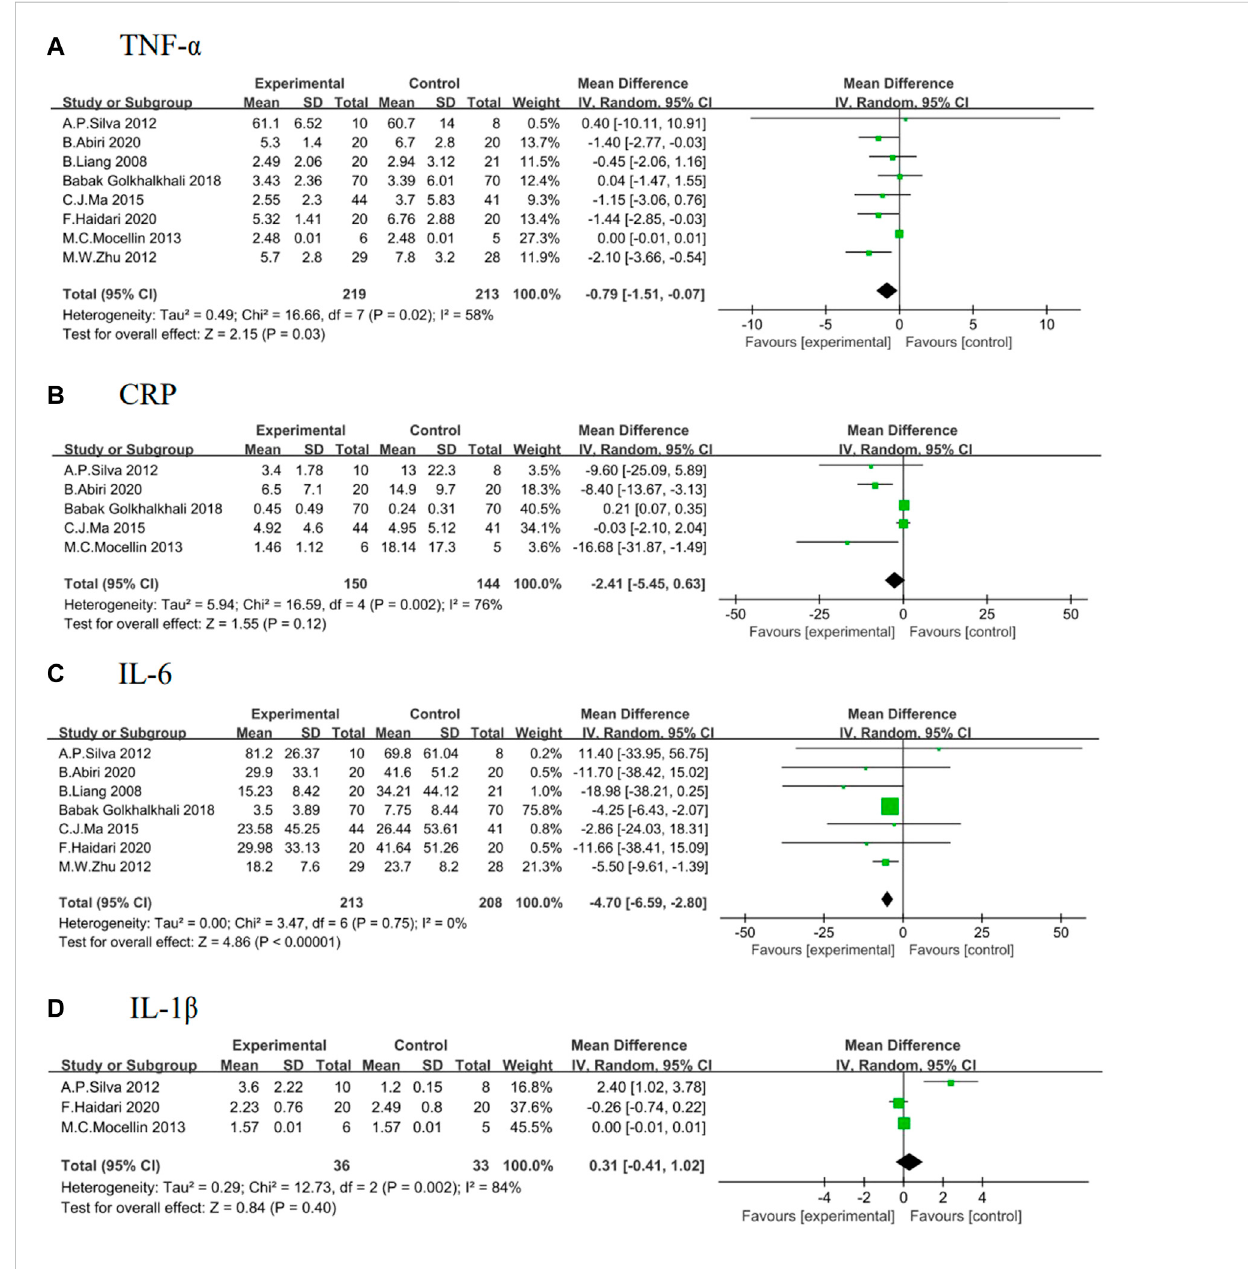
FIGURE 3 Effect of O3FAs on postoperative level of in fl ammatory factor (A) : TNF- α , (B) : CRP, (C) IL-6, (D) : IL-1 β .